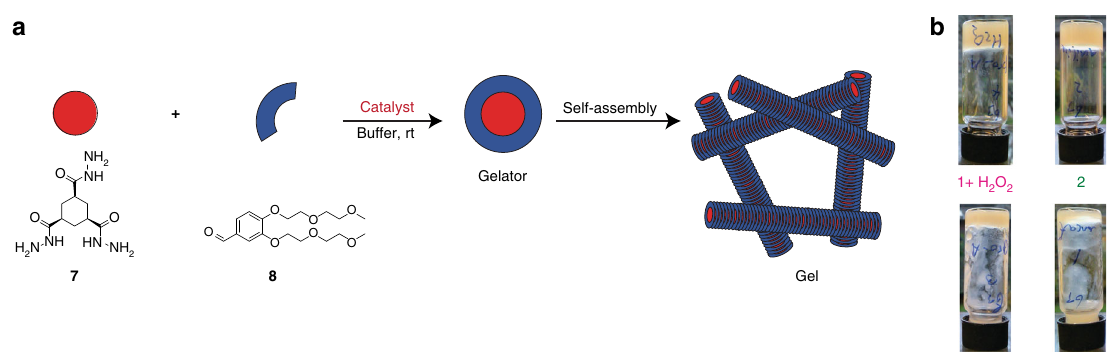
Fig. 4 Supramolecular gel formation controlled by the activation of pro-aniline 1 . To demonstrate the versatility of the pro-aniline system, we used the pro- aniline 1 to control the formation of a supramolecular gel 18 . a Schematic representation of the two water-soluble building blocks aldehyde 8 and hydrazide 7 that react by hydrazone formation in the presence of a catalyst to form a gelator, which stacks into fi bres and forms a gel. b We performed a gelation test for the supramolecular gel in vials. Photographs of gelation samples taken after 15 h of reaction time for the mixture (16 mM hydrazide 7 and 96 mM aldehyde 8 in 20% methanol in phosphate buffer, 100 mM, pH 6.0) with, top left: pro-aniline 1 (10 mM) and H 2 O 2 (100 mM), top right: aniline 2 (10 mM), bottom left: unactivated pro-aniline 1 (10 mM), bottom right: without catalyst. The mixtures with aniline 2 or pro-aniline 1 with H 2 O 2 formed gels after 15 h, whereas the mixture without catalyst or with unactivated pro-aniline 1 did not form gels, although the viscosity of the mixtures was increased after